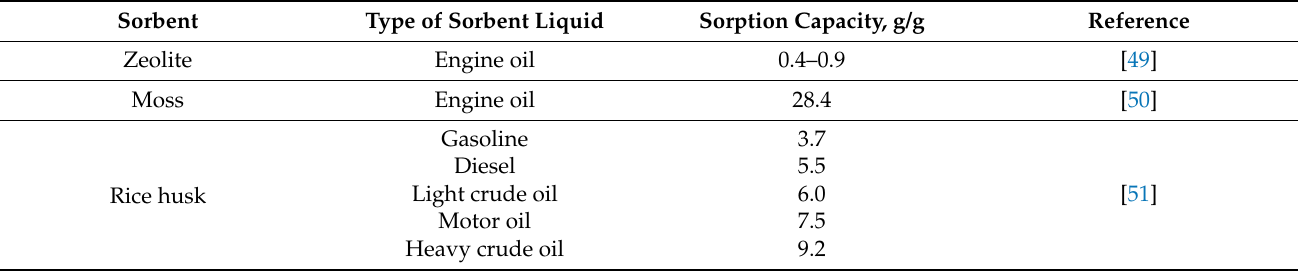
Table 10. Sorption properties of some petroleum and oil